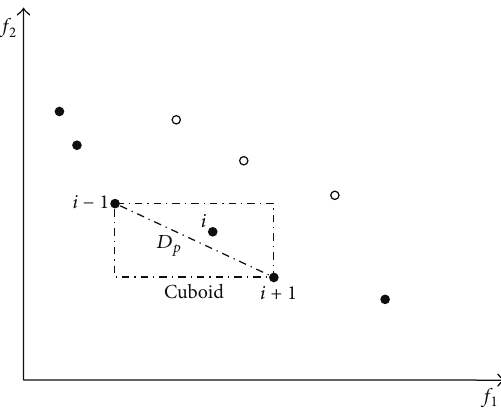
Figure 1: Crowding-distance calculation of the density estimation.